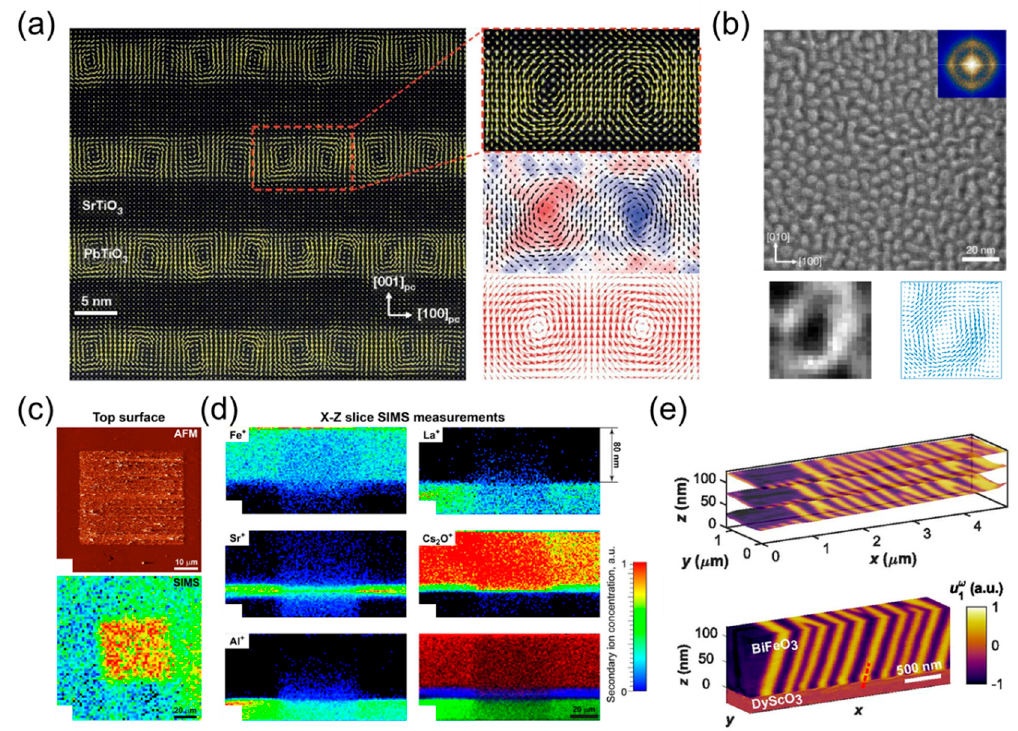
Figure 5. ( a ) Cross-sectional high-resolution STEM image with an overlay of the polar displacement vectors for a PTO 10 / STO 10 superlattice on DyScO 3 (DSO). A magnified image of a single vortex–antivortex pair, the curl of the polar displacement and the polarization vectors from a phase-field simulation of the same superlattice. Reprinted with permission from [100], copyright Springer Nature, 2016. ( b ) Planar-view dark-field STEM imaging shows the widespread occurrence of circular features in a (PTO 16 / STO 16 ) 8 superlattice with an inset of the FFT of the image, corresponding to the reciprocal space studies. Below are the images of a single skyrmion bubble with the mapped polarization vectors. Reprinted with permission from [101], copyright Springer Nature, 2019. ( c ) Top surface topography and secondary Bi + ions distribution. ( d ) XZ depth profiles of secondary ion concentrations. Reprinted with permission from [104], copyright 2016 American Chemical Society. ( e ) Tomographic reconstruction of ferroelectricity from a BFO thin-film heterostructure. Reprinted with permission from [107], copyright 2019 National Academy of Sciences.